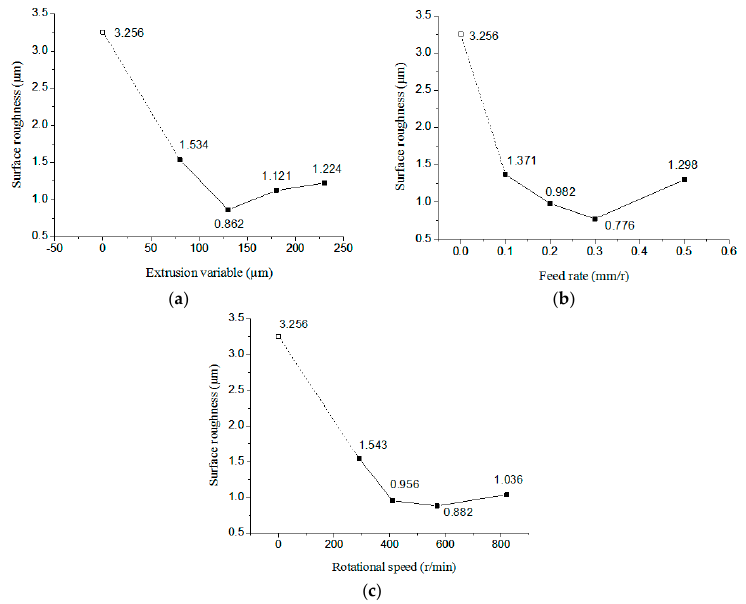
Figure 8. The variation tendency of surface roughness with different parameters. ( a ) Effect of the extrusion variable; ( b ) Effect of the feed rate; ( c ) Effect of the rotational speed. In summary, after ultrasonic surface strengthening based on rare-earth giant magnetostrictive ultrasonic transducer, the surface quality of the test-pieces has been significantly improved. The surface roughness can be reduced by about 75% and the hardness can be increased by more than 20%. Therefore, the application of rare-earth giant magnetostrictive ultrasonic transducer in ultrasonic surface strengthening technology is a valuable research direction.